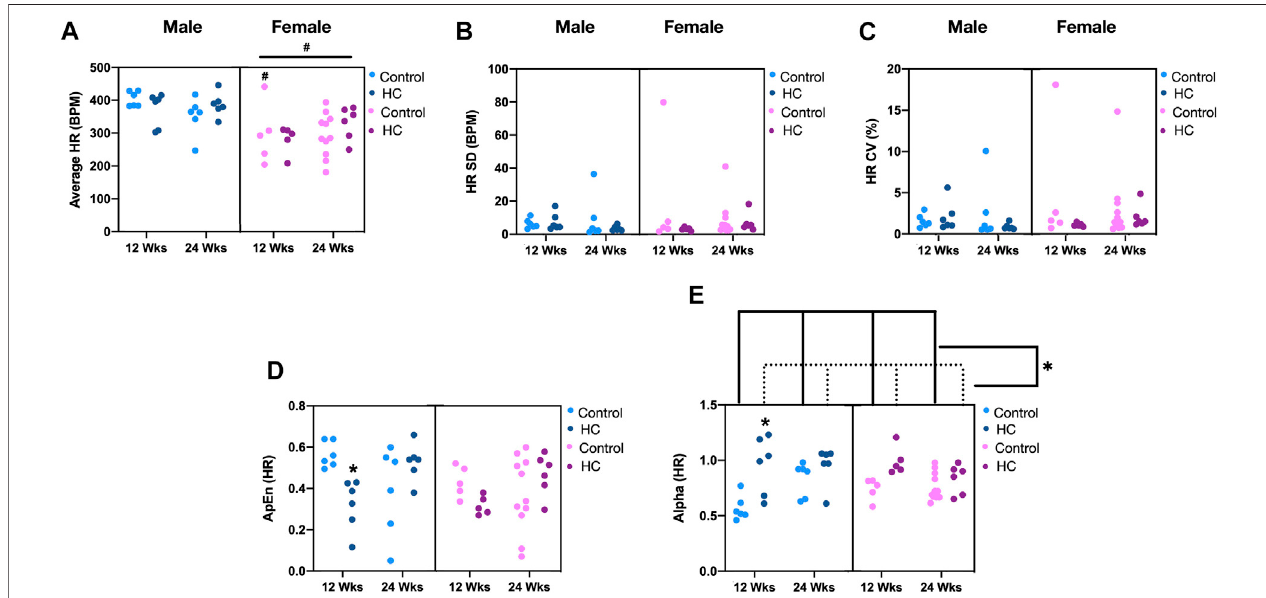
FIGURE3 | Impact ofHC feedingon averageHR and linear and nonlinear parameters ofbeat-to-beat HRV in rats ofeither sexindifferentfeedingdurationgroups. (A) Average, (B) standarddeviation(SD), (C) coef fi cientofvariation(CV), (D) approximateentropy(ApEn),and (E) α ofdetrended fl uctuationanalysisofHRincontroland HC-fed rats of either sex in different feeding duration groups. Statistical analysis was performed by three-way ANOVA followed by Sidak ’ s multiple comparison test. * denotes a p < 0.05 vs. control of the same feeding duration and sex (control vs. HC), while # denotes a p < 0.05 vs. the corresponding male group (males vs.